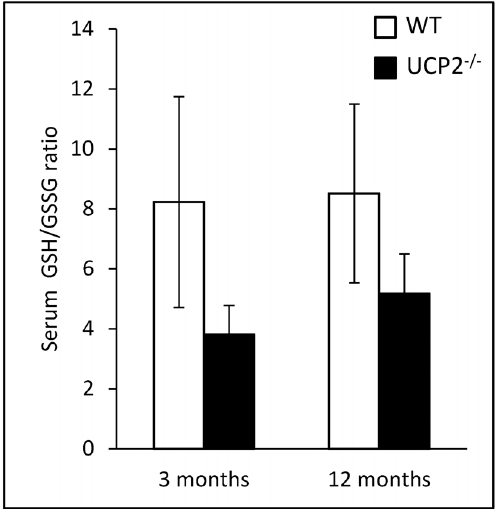
Figure 1. Analysis of redox status in serum of WT and UCP2 -/- mice. Serum samples of 3 and 12 months old UCP2 -/- and WT C57BL/6 mice (n=7–8) were used to measure total GSH and GSSG levels. Data are given as GSH/GSSG ratio (mean 6